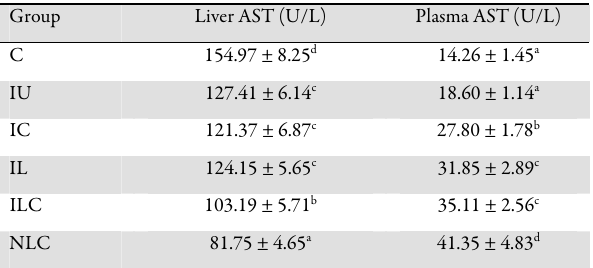
Table 4. The effect of lumefantrine and lumefantrine - copper complex on the specific activity of aspartate aminotransferase in the liver and plasma of P.